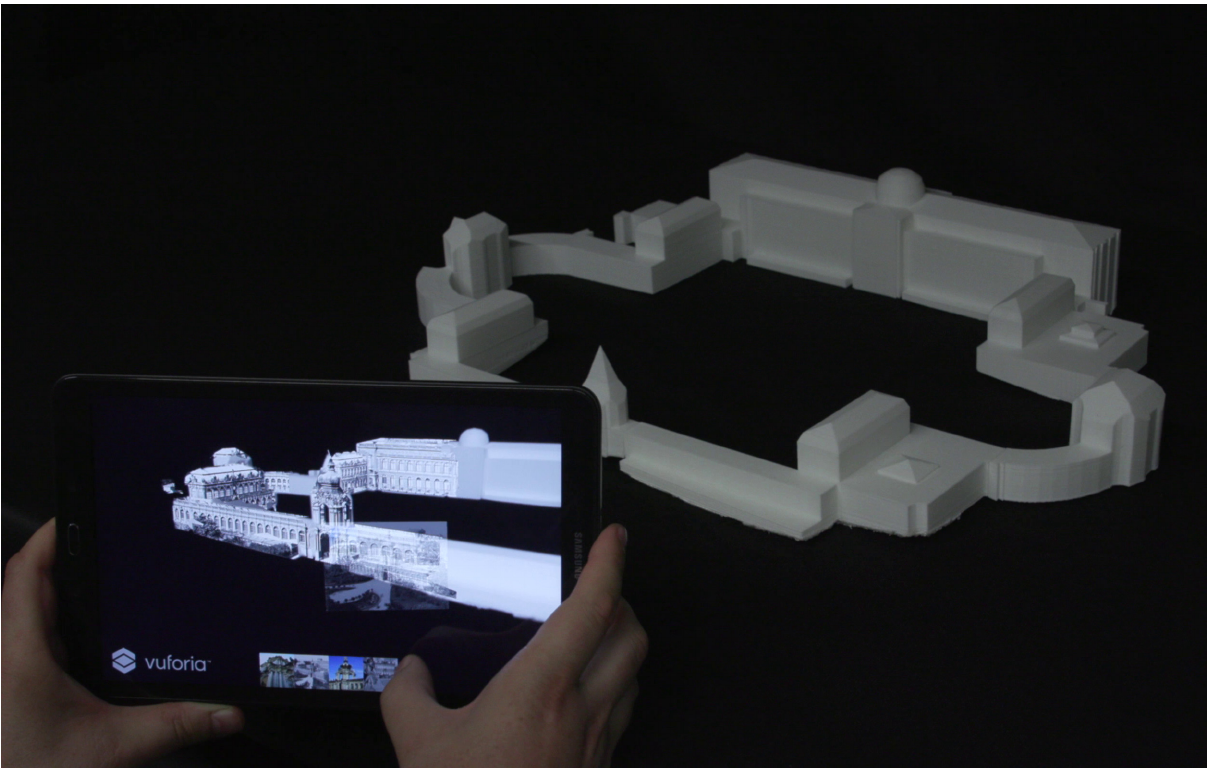
Figure 7. Augmented Reality installation using historical photography as textures for 3d-printed model of architecture